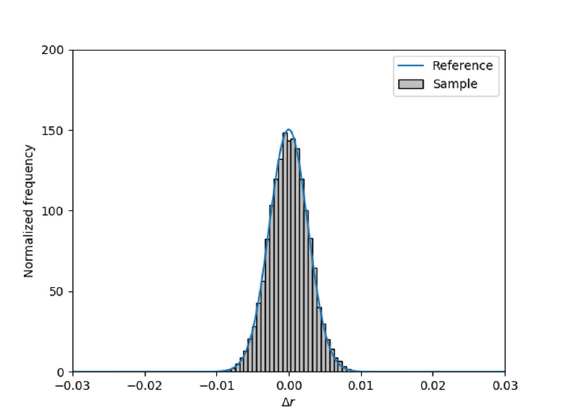
Fig. 3. Histogram of 𝛥𝑟 (when 𝐕(cid:3553) 𝐦 (cid:3404) 𝐕 𝐦 )